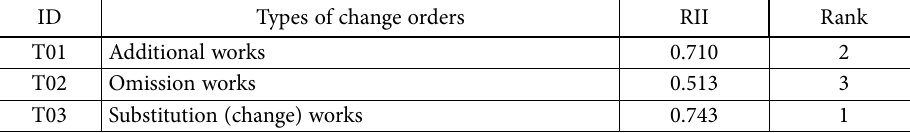
Table 3. RII results and ranking for types of change